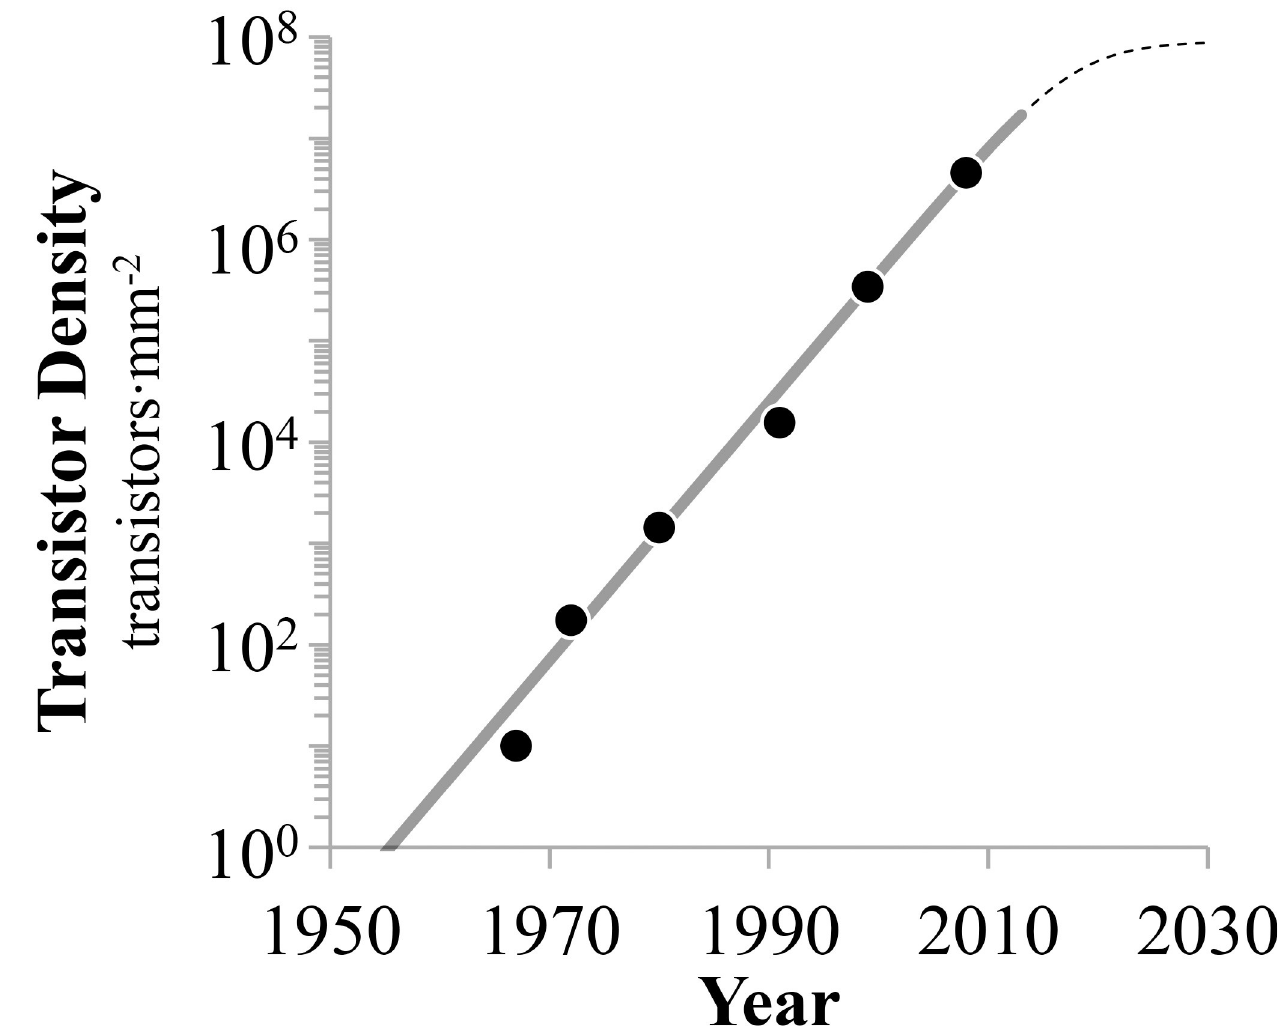
Fig 8. A “hyperlogistic” function fitted to the inflection points of the six identified logistic wavelets.